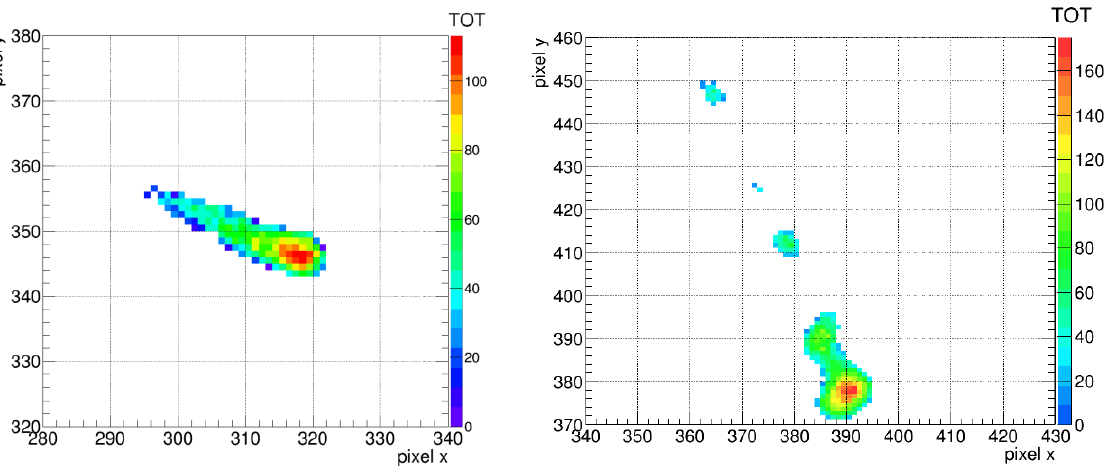
Figure 15. Examples of particle tracks measured with the GEMPix: a proton track (from neutron irradiation) with a visible increase in the energy deposition towards the end of the track ( left ) and an electron track (from 137 Cs irradiation, right ).